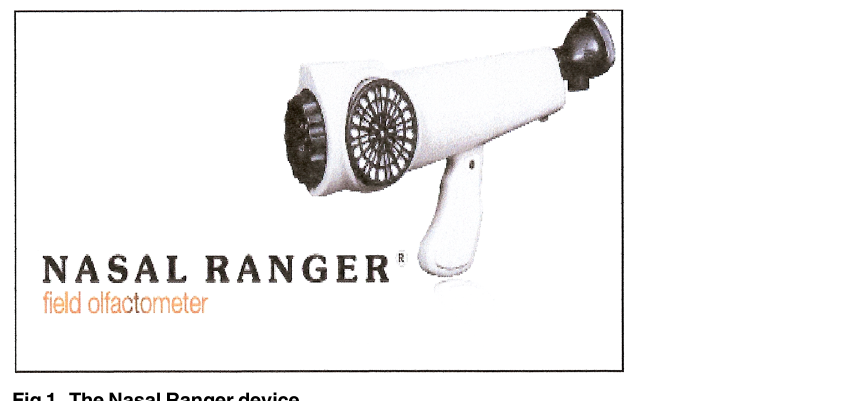
Fig 1. The Nasal Ranger